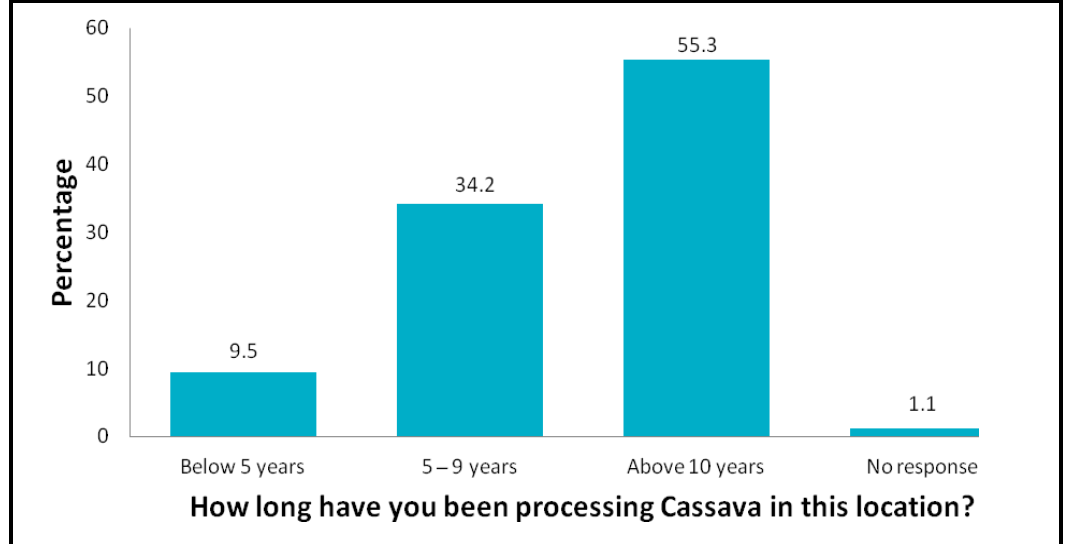
Figure 8. Number of years respondents have worked in cassava processing. Table 1. Cassava-processing operations in the selected local government areas